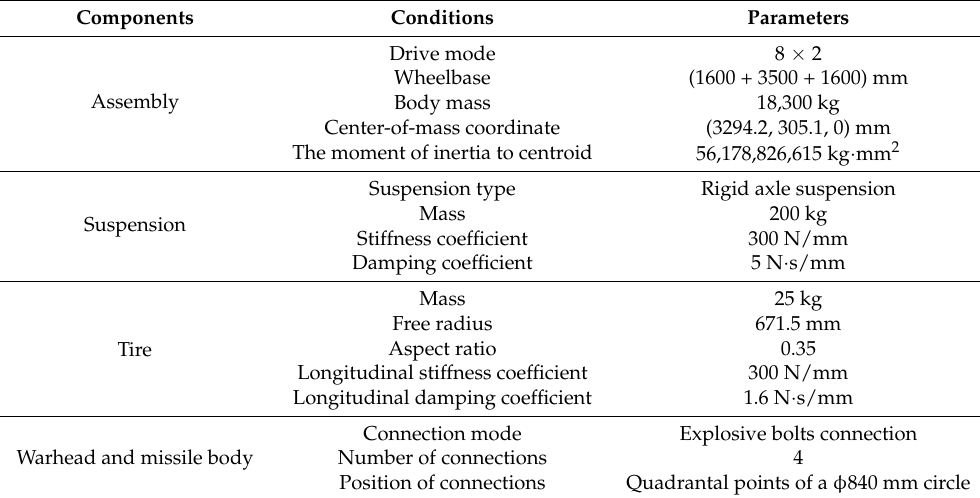
Table 1. Parameters of the missile and the carrying vehicle.